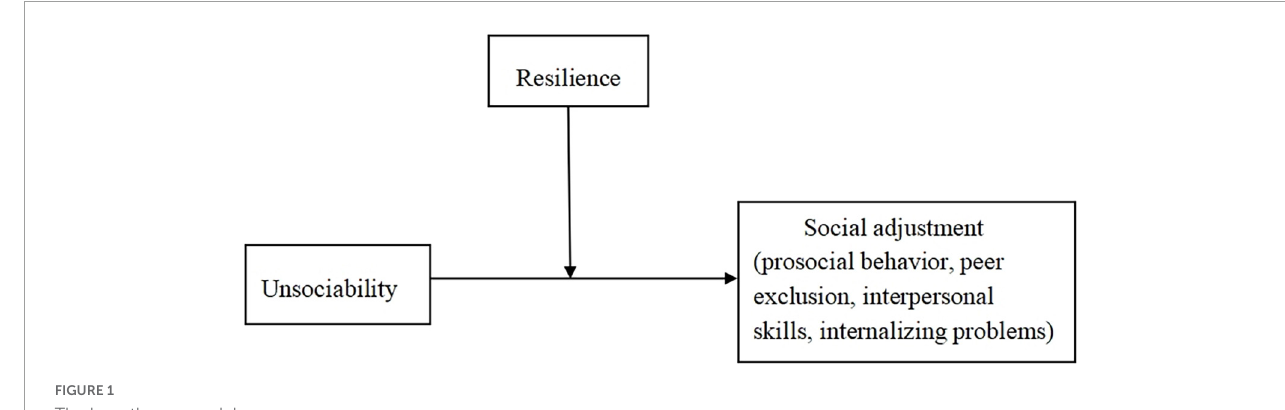
FIGURE1 The hypotheses model.